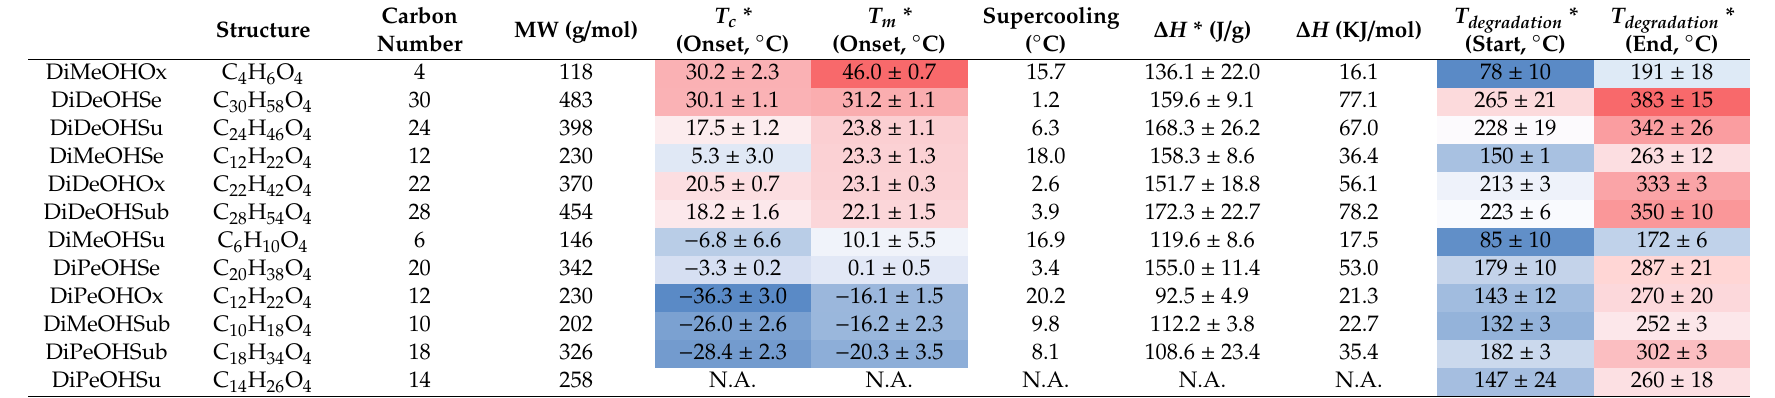
Table 2. Summary of thermal properties of the diesters produced.